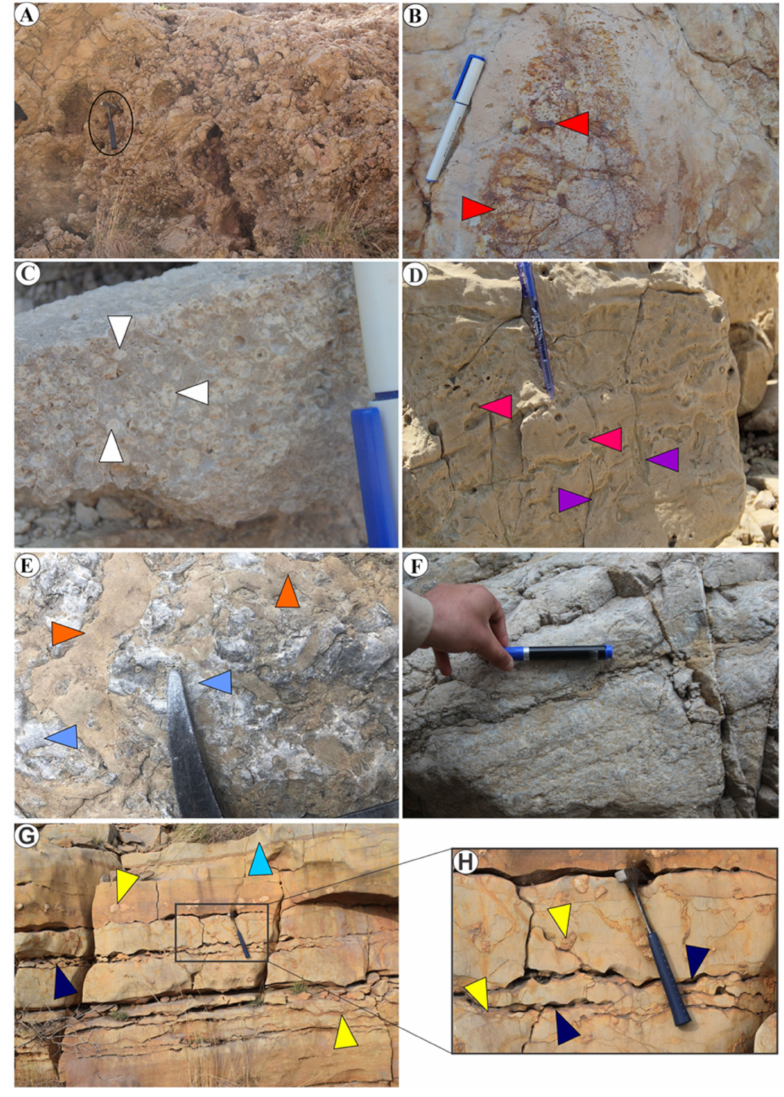
Figure 3. Field photographs ( A ) Exposure of brown color massive-brecciated unit in the middle part of the Kingriali Formation. This brecciated bed possesses clasts of the same formation bounded mostly by dolomite cement. ( B ) During subaerial exposure, the red arrow illustrates the deposition of laterite along the dissolution pits ( C ) Micritic envelops along ooid grains were observed during field investigations. Some of the ooids and peloids are completely micritized during the early stage of marine diagenesis (white arrows). ( D ) Filled burrows (purple arrows), oncoids (pink arrow), and moldic porosity formed by the dissolution of oncoids. ( E , F ) shows partially dolomitized limestone bed. Different sets of stylolites ( F ) were observed, some of them are wide open due to dissolution phenomenon, while other are closed. The burial dissolution-induced vugs along the stylolites are mostly filled with saddle dolomite in ( F ). Patches of brown dolomite (orange arrows) have wrapped the unaltered part of host limestone (blue arrows). ( G , H ) shows interbedded dolomitized and partially dolomitized limestone bed (light blue arrow). Different sets of stylolites (dark blue arrows) were observed. The dissolution induced vugs along the stylolites are mostly filled with saddle dolomite (yellow arrows). A bead of cavity filling saddle dolomite was observed along stylolite (yellow arrow) and immediately above the amplitude of stylolite. Cavity filling saddle dolomite is associated with the completely replaced dolomitized beds, while the stylolite along the partially replaced limestone are still unfilled (dark blue